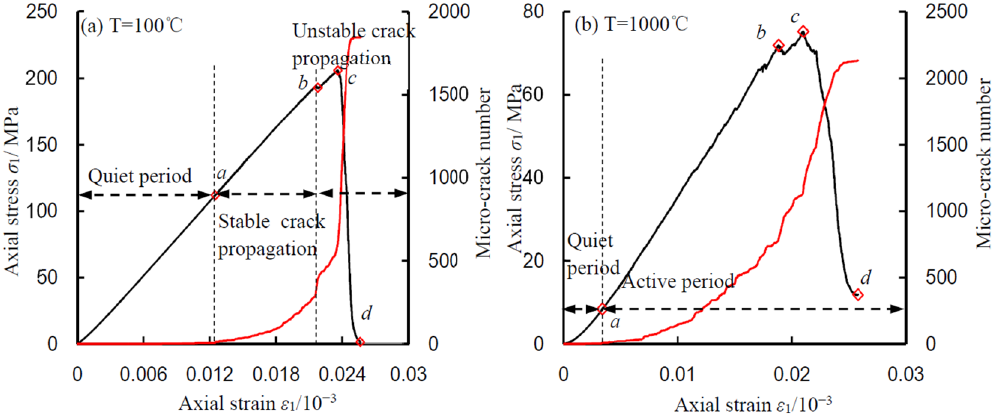
Figure 8. Cumulative micro-crack counts vs. axial stress for granite specimens: ( a ) T = 100 °C; and ( b ) T = 1000 °C.